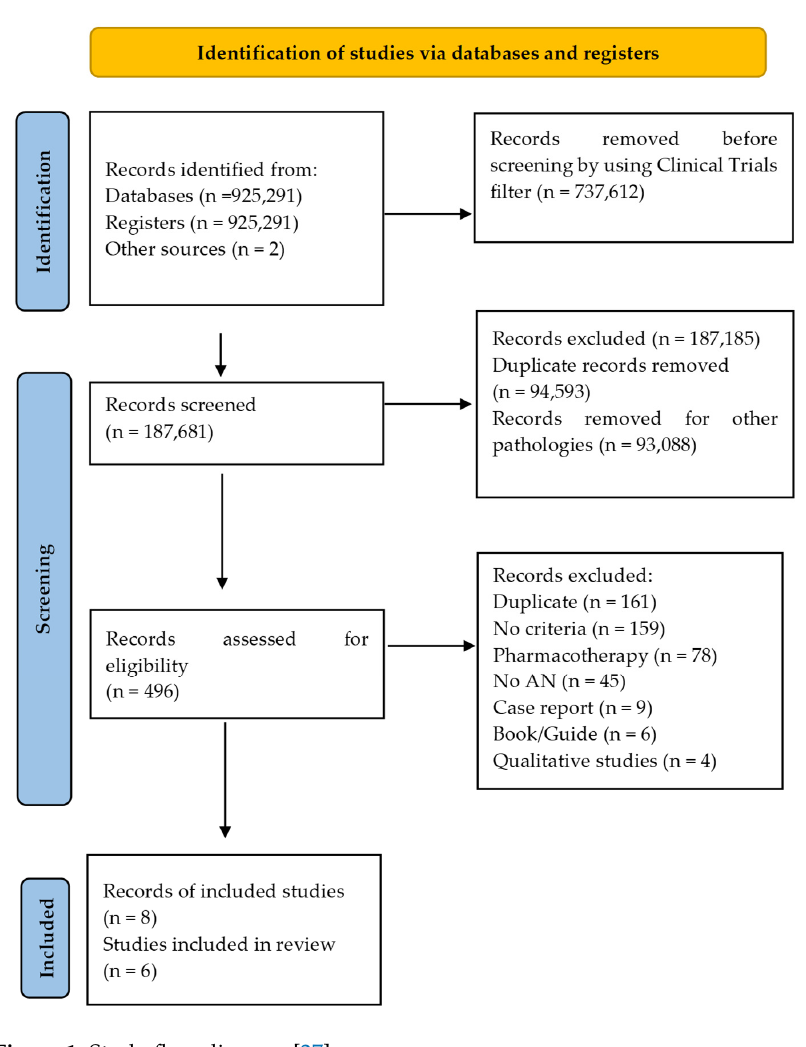
Figure 1. Study flow diagram [27].